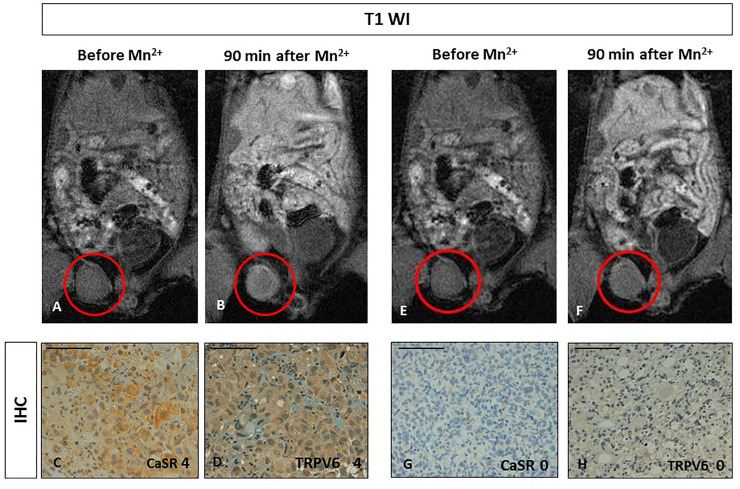
Manganese Enhanced MR Imaging (MEMRI) of orthotopic human breast cancer xenografts and CaSR/TRPV6 receptors levels.AB. Tumour diameter 5 mm. Upon comparing T1-weighted gradient echo images (T1 WI) recorded before and 90 minutes after Mn2+ administration, the tumour showed manganese uptake (red circles). CD. Immunohistochemistry (IHC) of CaSR and TRPV6: both receptors are detected (score 4) with a homogenous intense staining. Scale bar = 100μ. EF. Tumour diameter 5 mm. Upon comparing T1-weighted gradient echo images (T1 WI) recorded before and 90 minutes after Mn2+ administration, no changes in tumour signal enhancement was appreciated (red circles). GH. Immunohistochemistry (IHC) showed no evidence for CaSR and TRPV6 expression (score 0). Scale bar = 100μ.